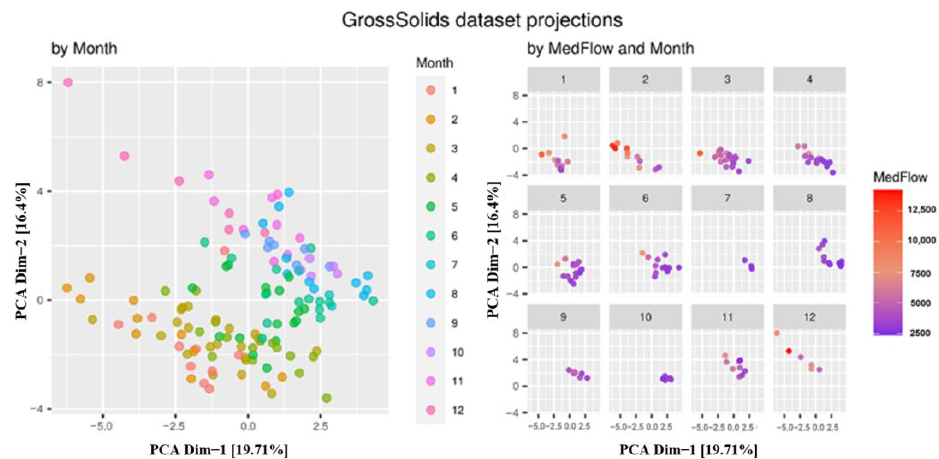
Figure 4. Principal component analysis (PCA) projection of the initial data